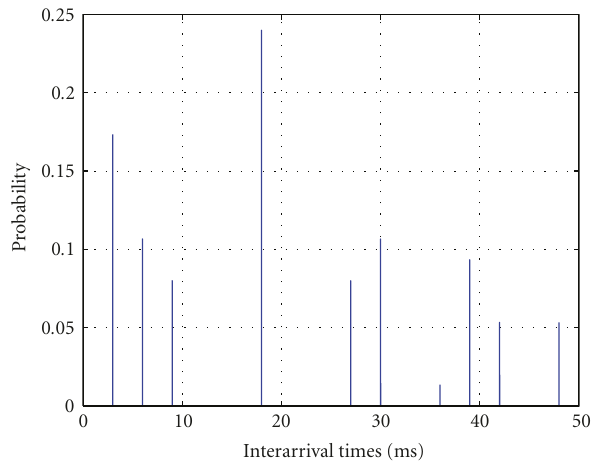
Figure 6: RT-Link PDF for 15%